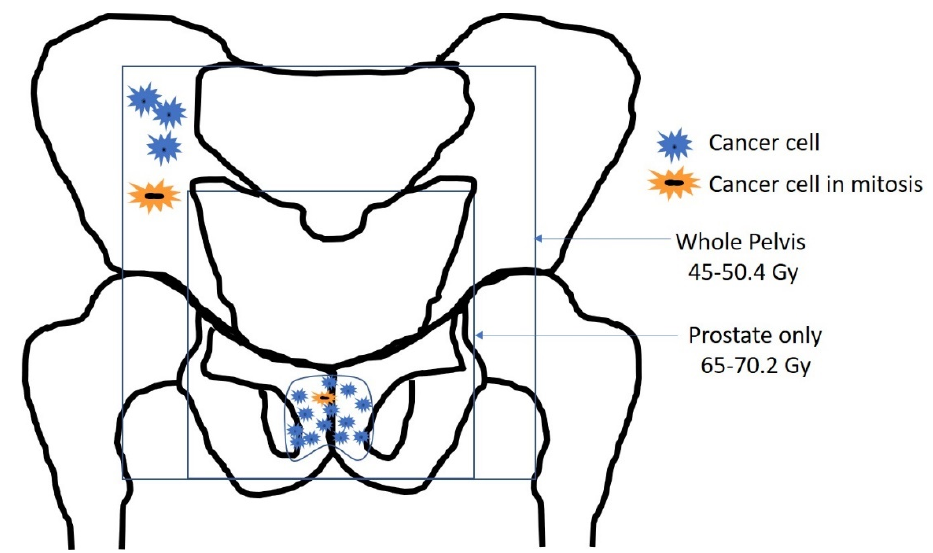
Figure 5. RTOG 9413 trial. Radiation therapy to prostate only (PO) was limited to the prostate and seminal vesicles, with a maximum unblocked field size of 11 × 11 cm to a total dose of 70.2 Gy, 1.8 Gy per fraction per day, 5 days a week. Radiation therapy to the whole pelvis was performed using a minimum unblocked field size of 16 × 16 cm to a maximum central axis dose of 50.4 Gy, followed with an additional 19.8 Gy to the prostate only. Suppression of prostate cancer cell mitosis by neoadjuvant ADT could result in resistance to radiation doses in the range of 45–50 Gy. Delivery of LHRH during radiation, as in RTOG 8531 and EORTC 22863, results in testosterone flare, driving tumor cells into mitosis during the radiation therapy course, rendering them sensitive to a dose per fraction of 1.8–2 Gy, and to cumulative doses in the range of 45 Gy, and leading to higher cancer cell death, and thus increased overall survival.